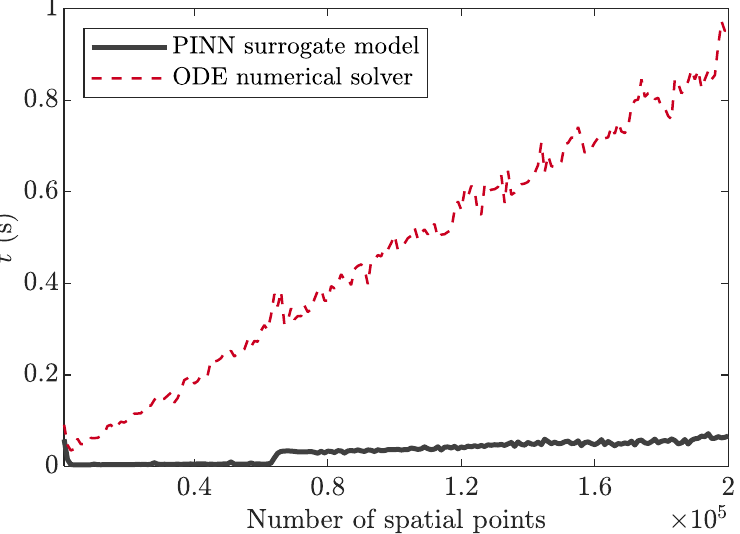
Figure 8. Comparison of calculation time between PINN surrogate model and ODE numerical solver with respect to the number of spatial points.